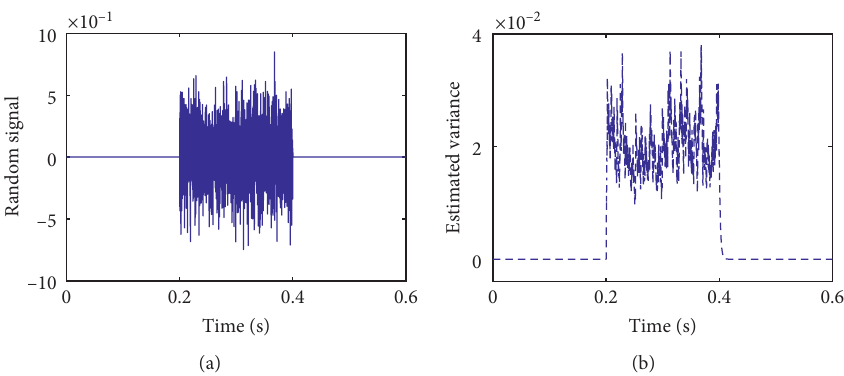
Figure 7: Variance estimation output of the random signal.